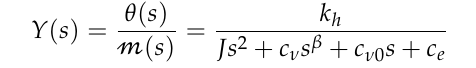
Figure 1. Exoskeleton Glove and its biomechanical